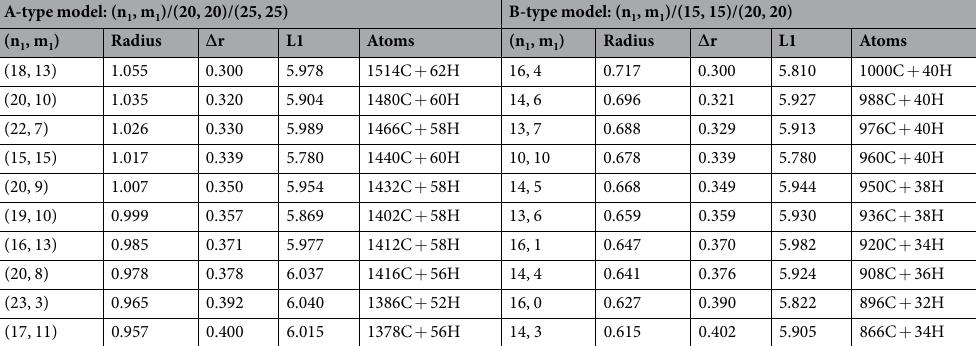
A-type model: (n 1 , m 1 )/(20, 20)/(25, 25)